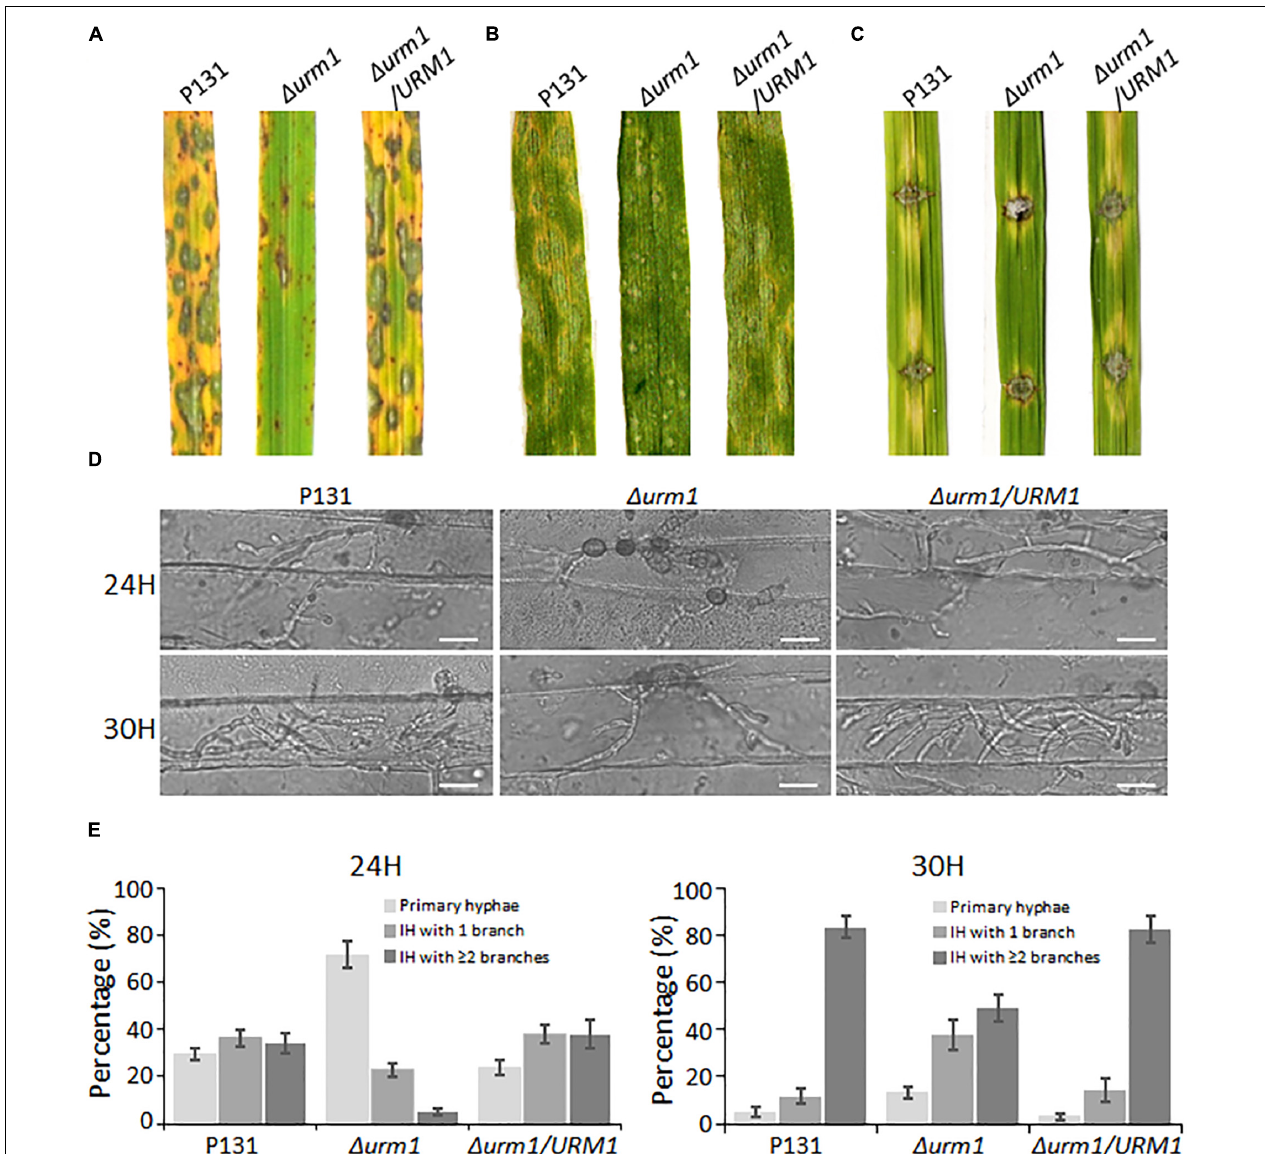
FIGURE 6 | The (cid:49) urm1 mutant showed attenuated pathogenicity. (A) Virulence test on rice seedlings. The rice cultivar is Oryza sativa cv. LTH. (B) Virulence test on barley leaves. The barley cultivar is Hordeum vulgare cv. E9. Conidia suspensions (1 × 10 5 conidia/ml) for each strain were sprayed on one-month-old rice seedlings and 7-day-old barley leaves. (C) Virulence test on wounded rice leaves. Rice leaves were slightly wounded by a needle before inoculation with a mycelial block of the wild type, (cid:49) urm1 mutant or complemented strain. Typical leaves were photographed at 5 dpi. (D) Colonization of the (cid:49) urm1 mutant on barley epidermis at 24 and 30 hpi. Bar, 25 µ m. (E) Statistical analysis for different types of the infection hyphae (IH) at 24 and 30 hpi. Means and standard errors were calculated from three independent replicates ( n >